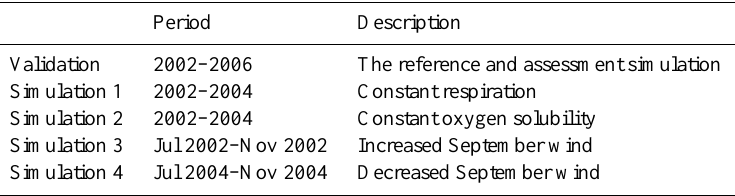
Table 3. Preformed simulations.